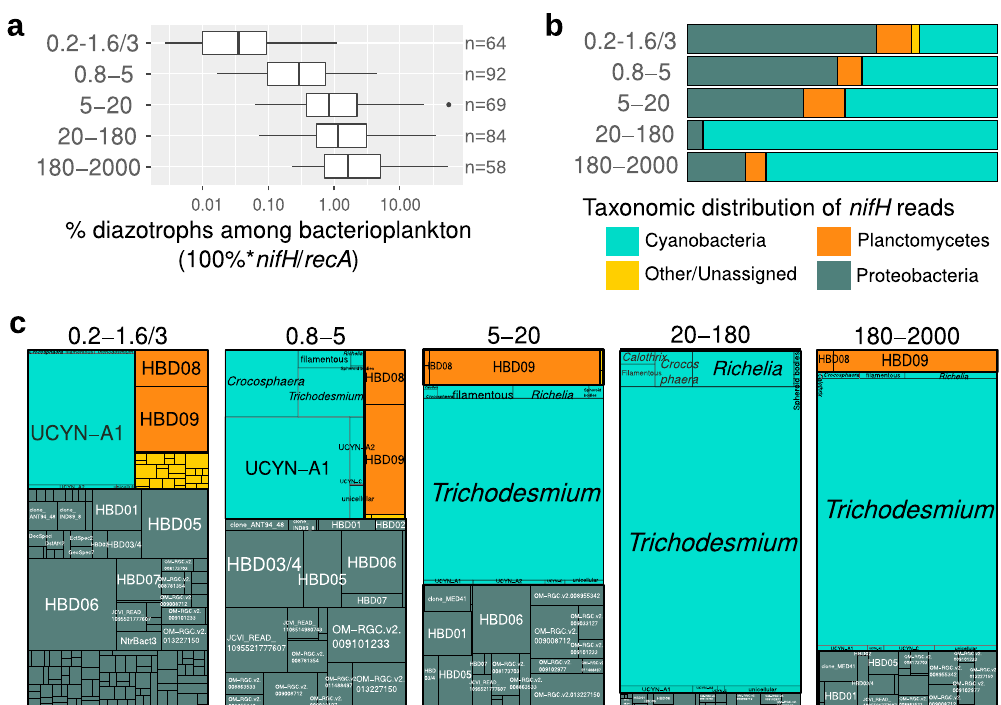
Fig. 5 Abundance of diazotrophs in surface waters using metagenomes obtained from different size-fractionated samples. a Diazotroph abundance. The percentage of diazotrophs in the bacterioplankton community was estimated by the ratio of metagenomic read abundance between the marker genes nifH and recA . b Taxonomic distribution of the nifH reads. c Taxonomic distribution at deeper resolution. HBD01 to HBD09 (heterotrophic bacterial diazotrophs) corresponds to the metagenome-assembled genomes from <3- µ m size fractions 16 . Boxplots depict the 25 – 75% quantile range of the dataset without zeros (the corresponding biologically independent seawater samples are indicated in the plot), with the center line depicting the median (50% quantile); whiskers encompass data points within 1.5× the interquartile range. Source data are provided as a Source data fi